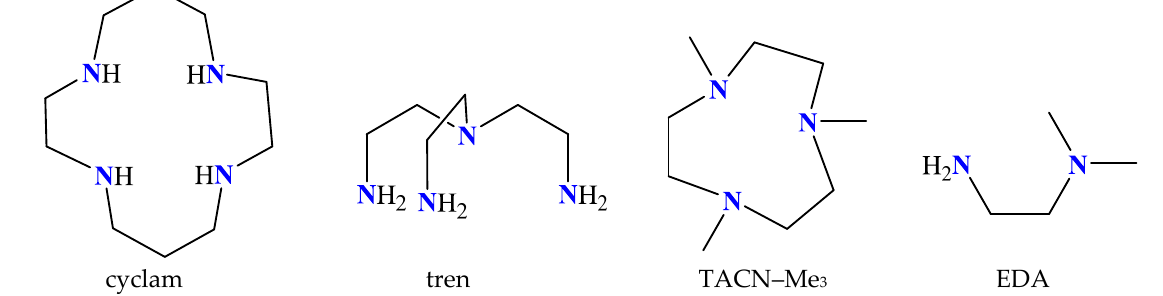
Figure 11. The syntax formula of the nitrogen–donors: cyclam = 1,4,8,11–tetraazacyclotetradecane; TACN–Me 3 = 1,4,7–trimethyl–1,4,7–triazacyclononane; tren = tris(2–aminoethyl)amine and EDA = N,N–dimethylethane–1,2–diamine.